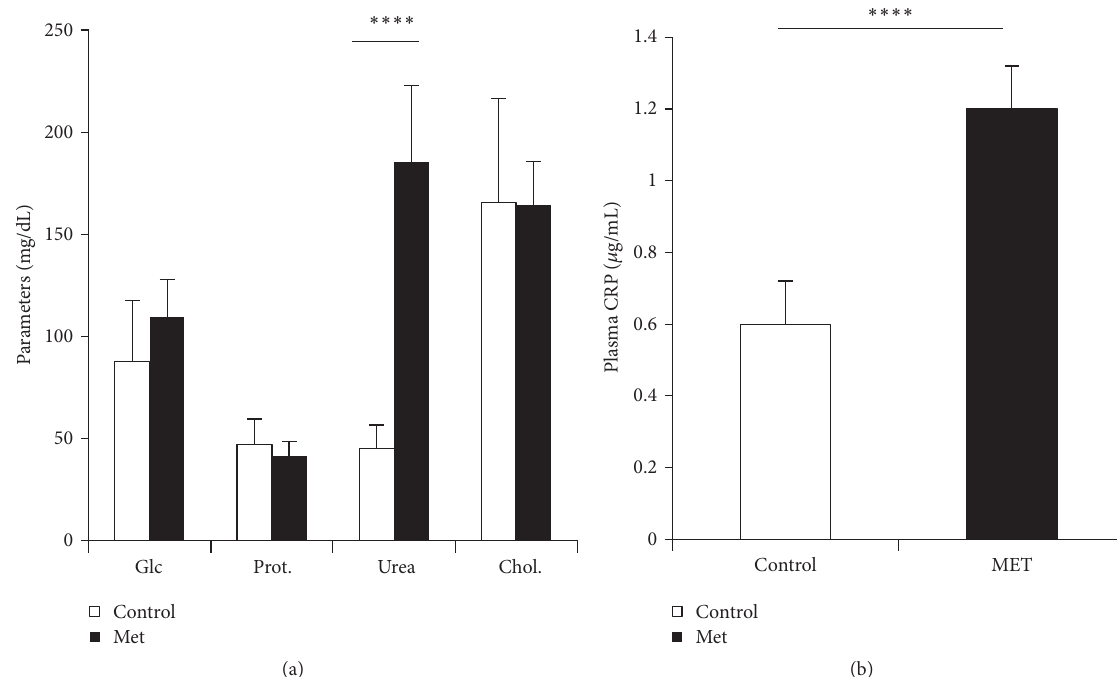
Figure 7: Plasma parameters of newborn rabbits. Glc: glucose, Prot: total proteins, and Chol: cholesterol. Control: offspring from control female rabbit (PC); Met: offspring from female rabbit submitted to Met (PMet); ∗∗∗∗ 𝑝 < 0.0001